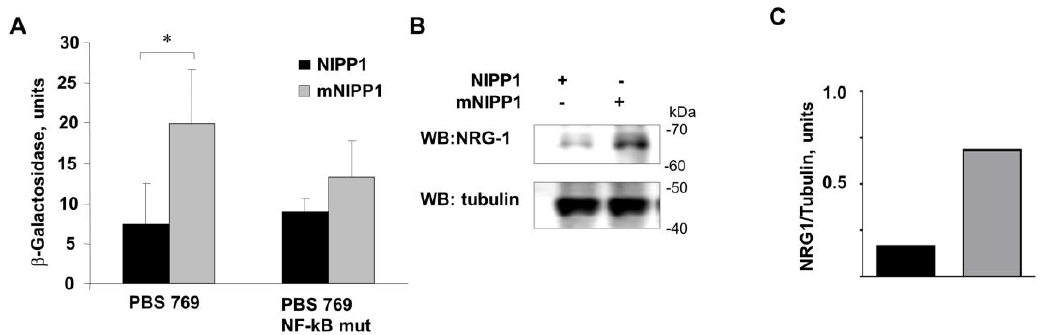
Figure 3. Expression of mNIPP1 increases transcription from the NRG-1 promoter. ( A ) HEK293T cells were transiently transfected with NIPP1-EGFP or mNIPP1-EGFP expressing vectors and co-transfected either with an expression vector in which LacZ expression was controlled by the NRG-1 promoter (PBS 769) or the NF-κB-mutated PBS 769 expression vector. Expression of LacZ was measured and normalized to EGFP expression. Mean and SD are shown. An asterisk (*) shows p value ≤ 0.05; ( B ) Expression of mNIPP1 induced endogenous NRG-1 expression in HEK293T cells. Cells were transfected with NIPP1-EGFP or mNIPP1-EGFP expression vectors. Cell lysates were resolved on 10% SDS-PAGE and analyzed by Western blot with anti-NRG-1 and anti-tubulin antibodies; ( C ) Quantification of panel B. NRG-1 expression is shown normalized to tubulin.